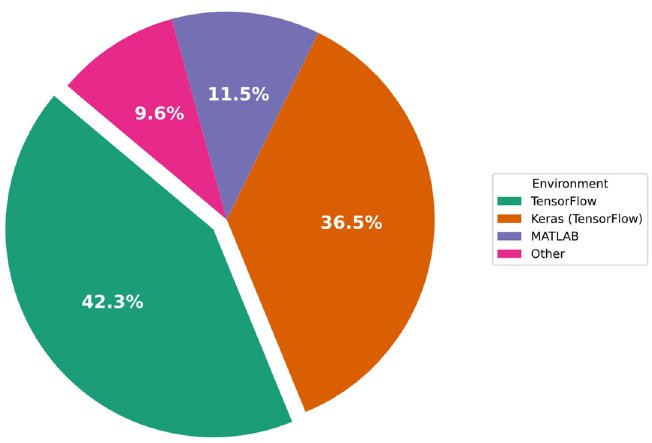
Figure 6. Percentages of datasets applied in CNN-IDS solutions.